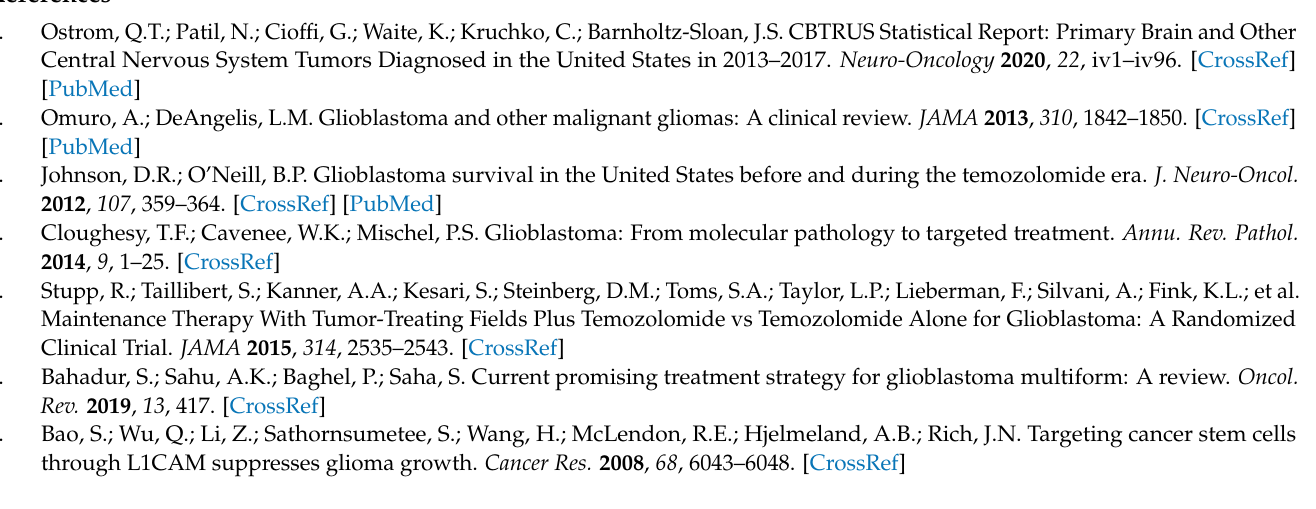
Figure S2: Western blotting of SREBP1 in U87MG and cell viability of U87MG overexpress SREBP2; Figure S3: TAK901 suppress histone H3 phosphorylation in GBM